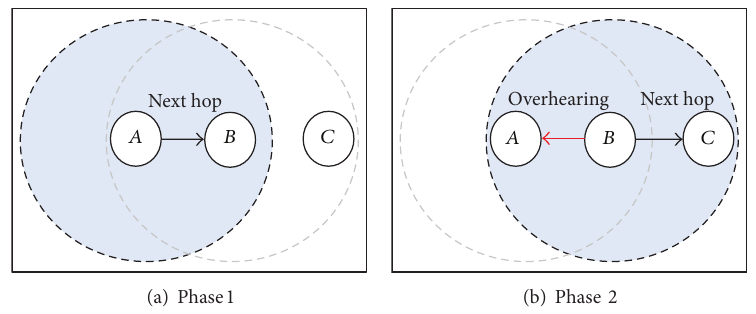
Figure 3: Updated probability